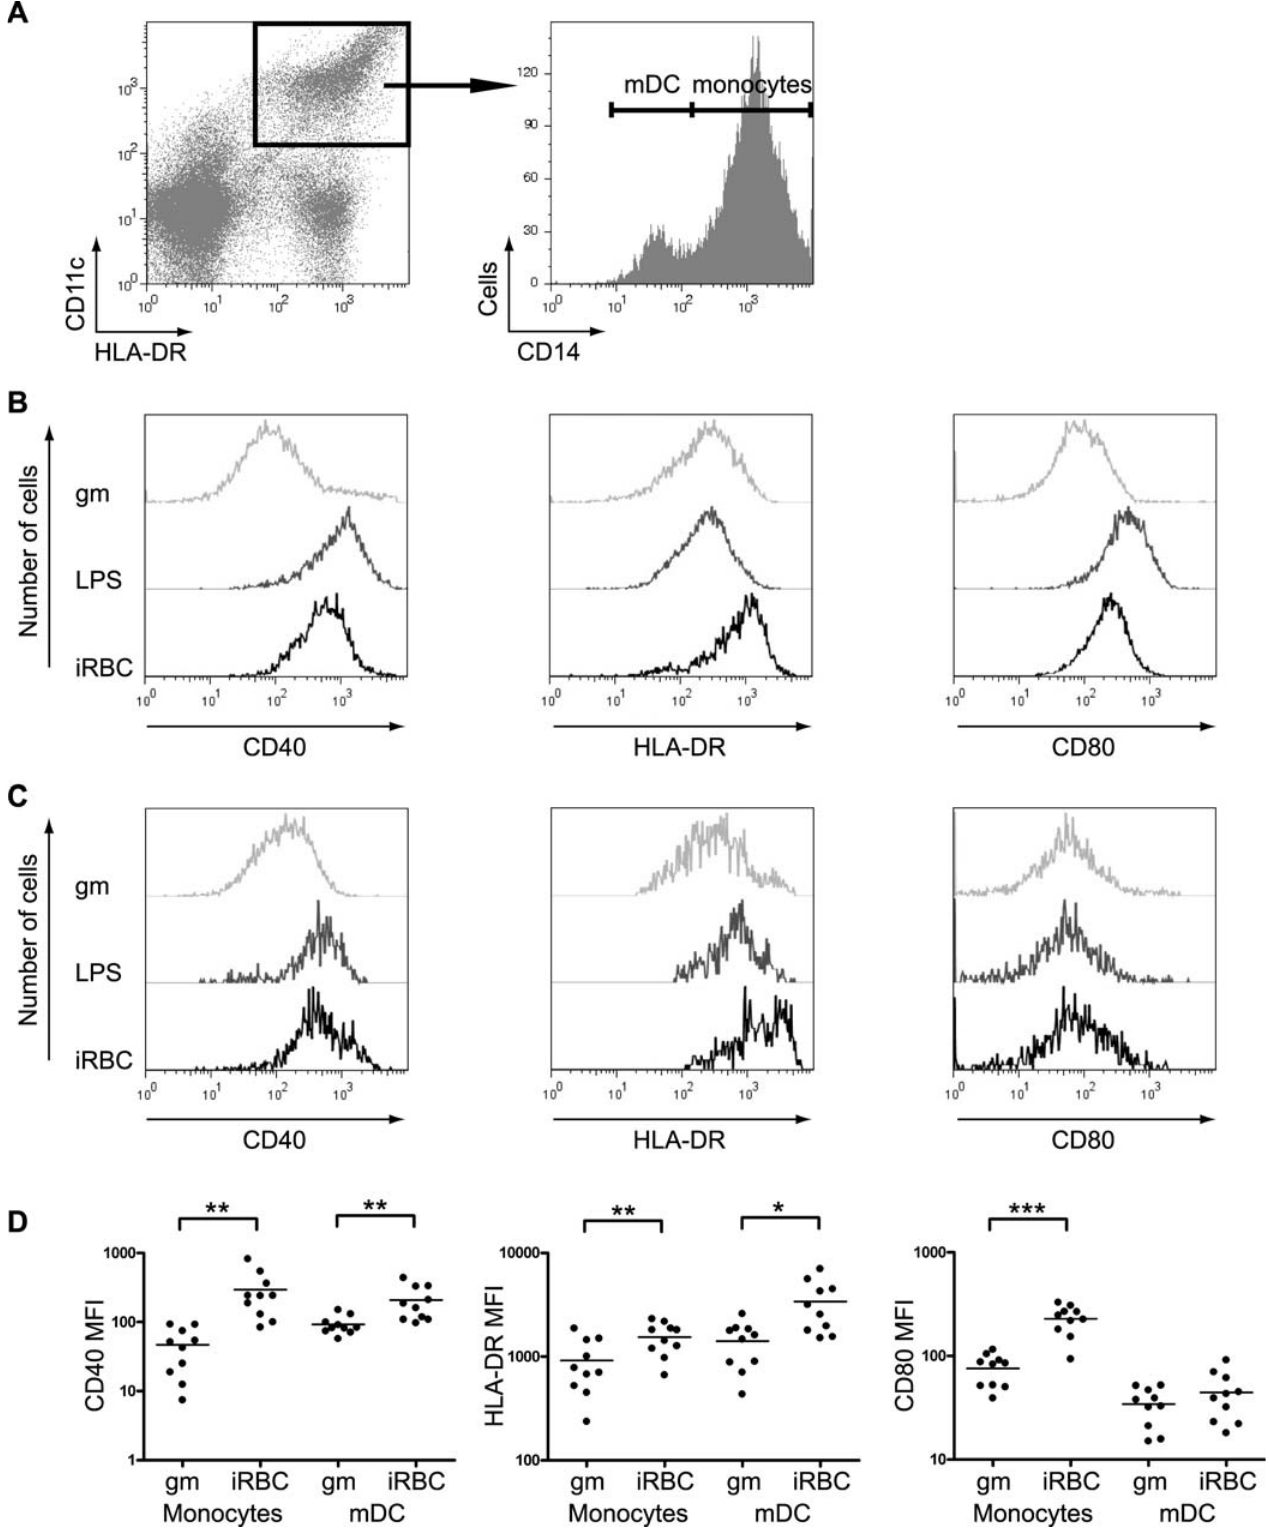
Figure 3. Accessory Cells Are Activated by iRBCs PBMCs from ten malaria-naı¨ve donors were cultured with live iRBCs or E. coli LPS for 24 h or left unstimulated. Surface expression of HLA-DR, CD40, and CD80 on accessory cells was analysed by flow cytometry. Accessory cells were defined as HLA-DR þ CD11c þ cells (A, left), and CD14 þ monocytes and CD14 (cid:1) mDCs were selected for further analysis (A, right). Representative examples of surface expression levels of CD40, HLA-DR, and CD80 on HLA-DR þ CD11c þ CD14 þ monocytes (B) and HLA-DR þ CD11c þ CD14 (cid:1) mDCs (C) are shown. Data are based on the collection of 100,000 total events. Results for all ten donors are summarised in (D). *, p , 0.05; **, p , 0.01; ***, p , 0.001; p -values are for paired t tests comparing stimulated and unstimulated cells from the same donor. doi:10.1371/journal.ppat.0020118.g003 PLoS Pathogens |